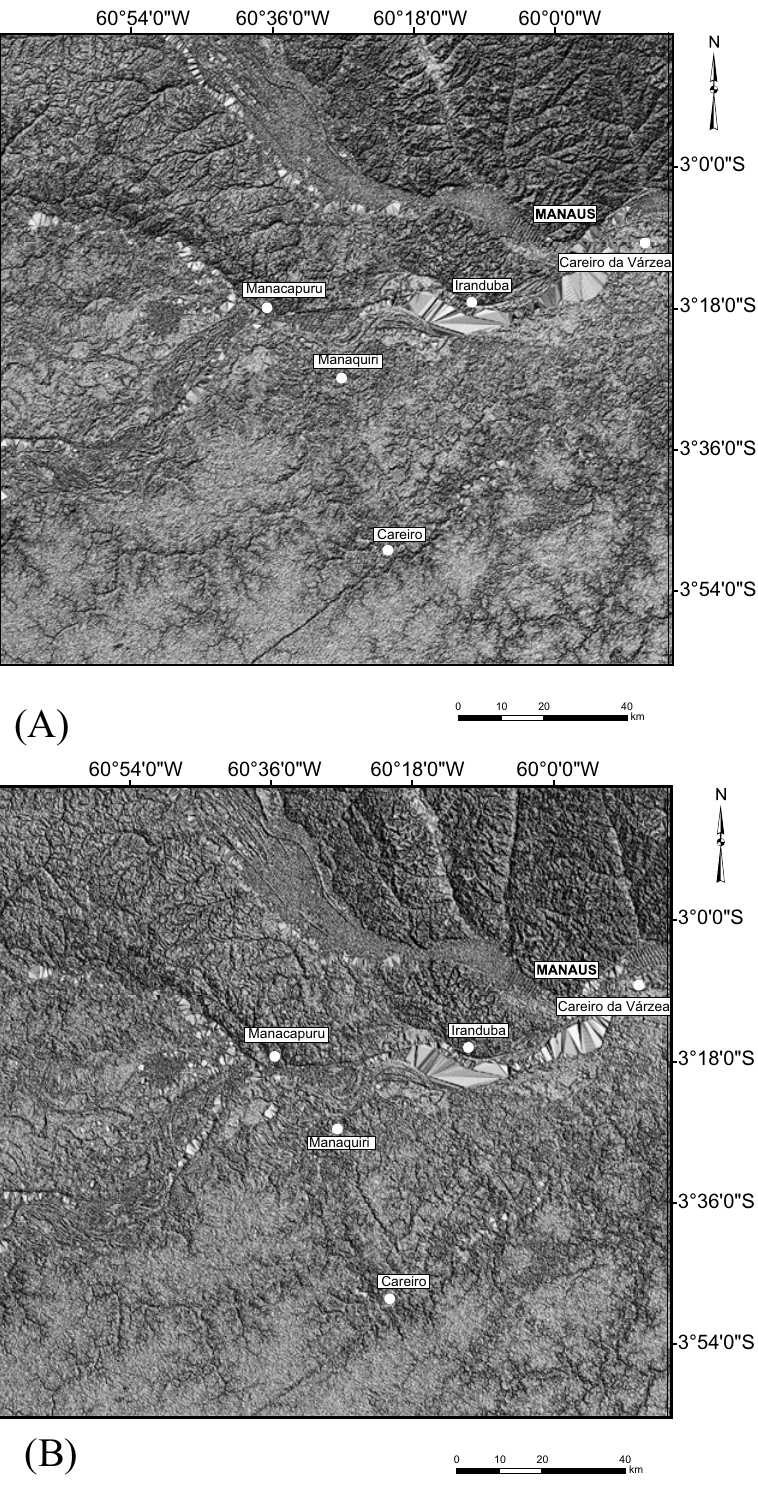
Fig. 3 – SRTM model of the southwestern region of Manaus (Amazon-Brazil). In (A) a synthetic shading filter was applied with azimuth 334 and elevation 58. In (B), with azimuth 62 and elevation 53, the latter used for enhancing the main morphostructural elements.